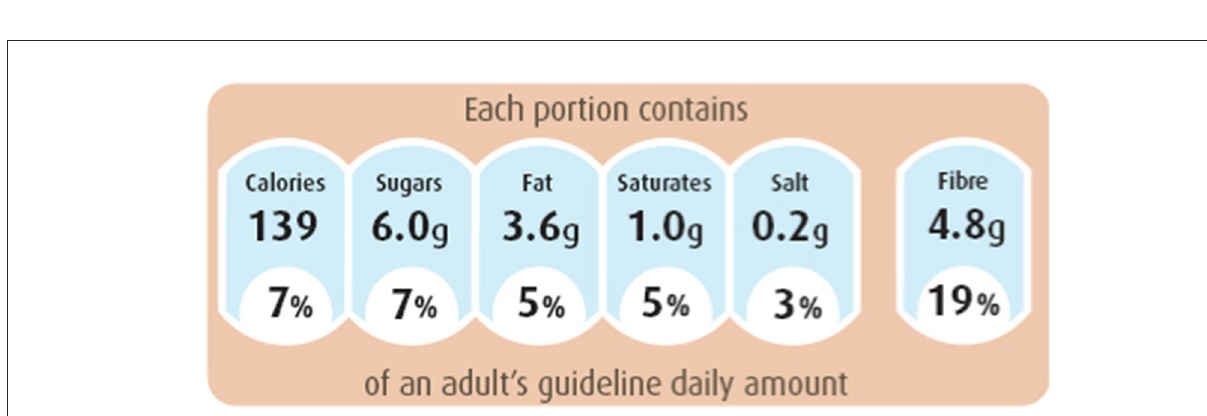
FIGURE2 GDA label. Image from https://wiki.ead.pucv.cl/index.php/Usuario:Romina_Guerra CC BY-SA 3.0.